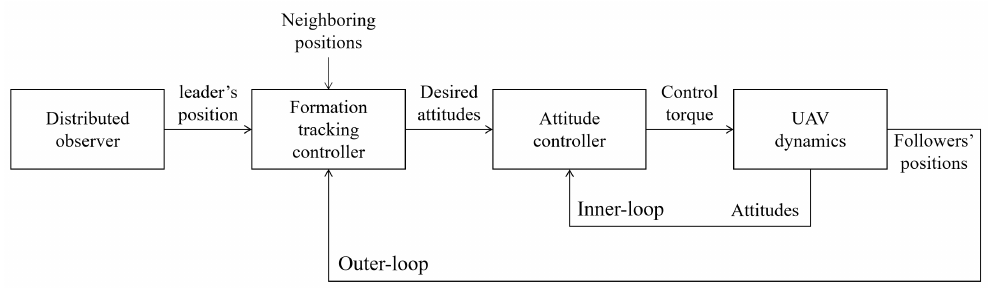
Figure 1. Two-loop TVFT control architecture for the UAV swarm